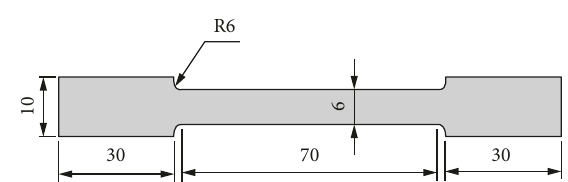
Figure 2: Geometrical shape with dimensions of the tensile specimen (All dimensions are in mm).